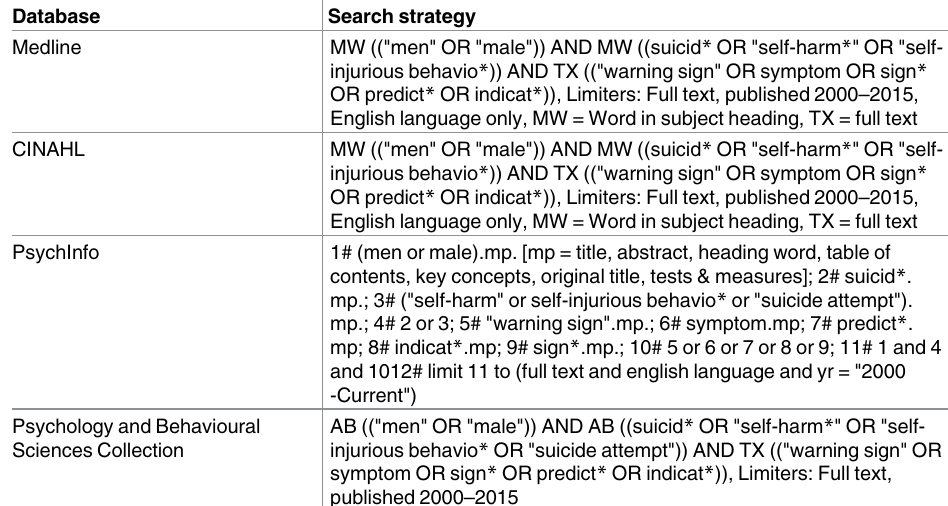
Table 1. Search strategy by